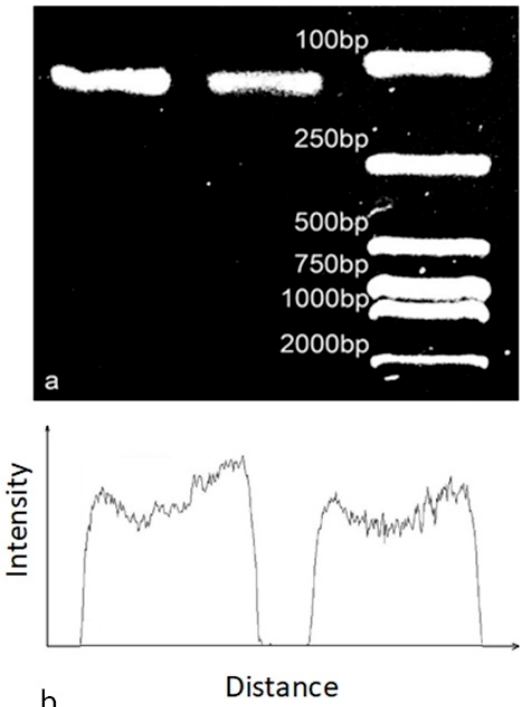
Figure 6. Electrophorogram and intensity diagram of contrast PCR experiments. ( a ) Electrophoretic results by commercial cycler ( left ), electrophoretic results by microdevice ( middle ) and the ladder ( right ). ( b ) The intensity diagram of commercial cycler PCR electrophoretic results ( left ) and microdevice PCR electrophoretic results ( right ).